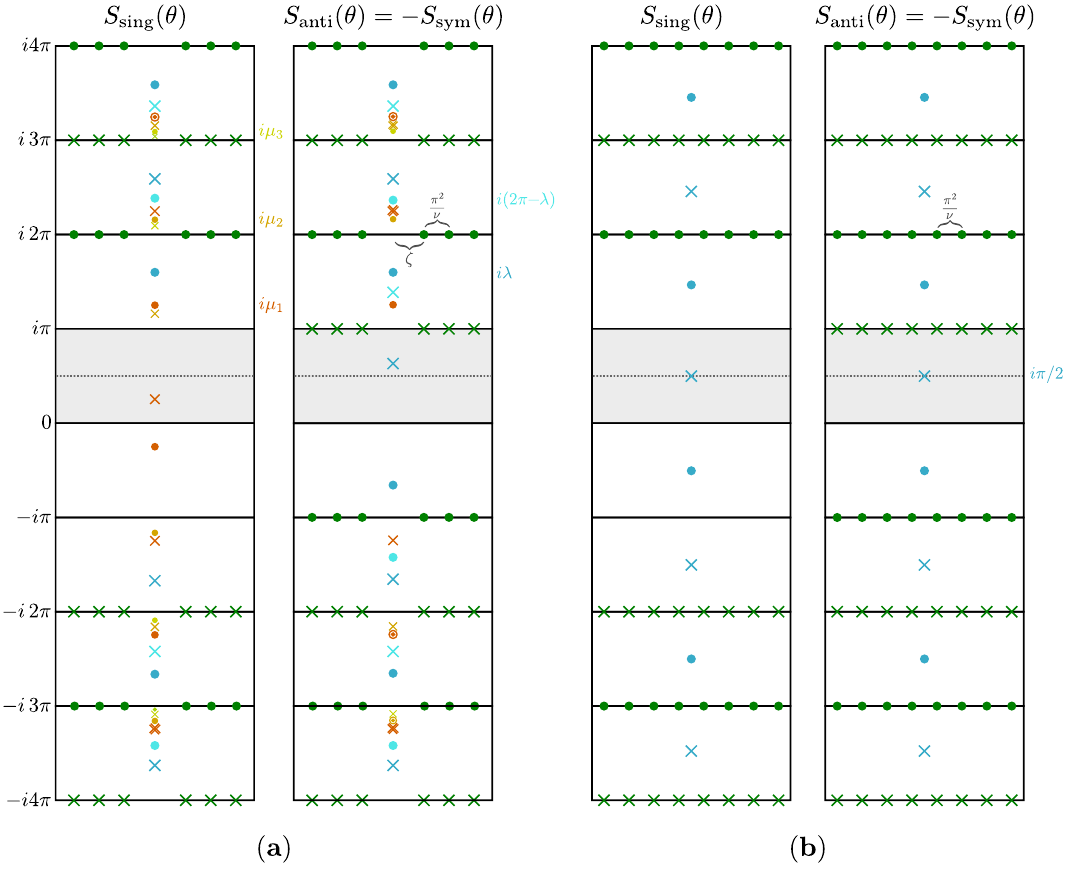
Figure 11 . ( a ) Analytic structure of solution along the (cid:27) 2 = 0 line given in (11). ( b ) The simple analytic structure remaining from (11) when (cid:21) = 3 (cid:25)=